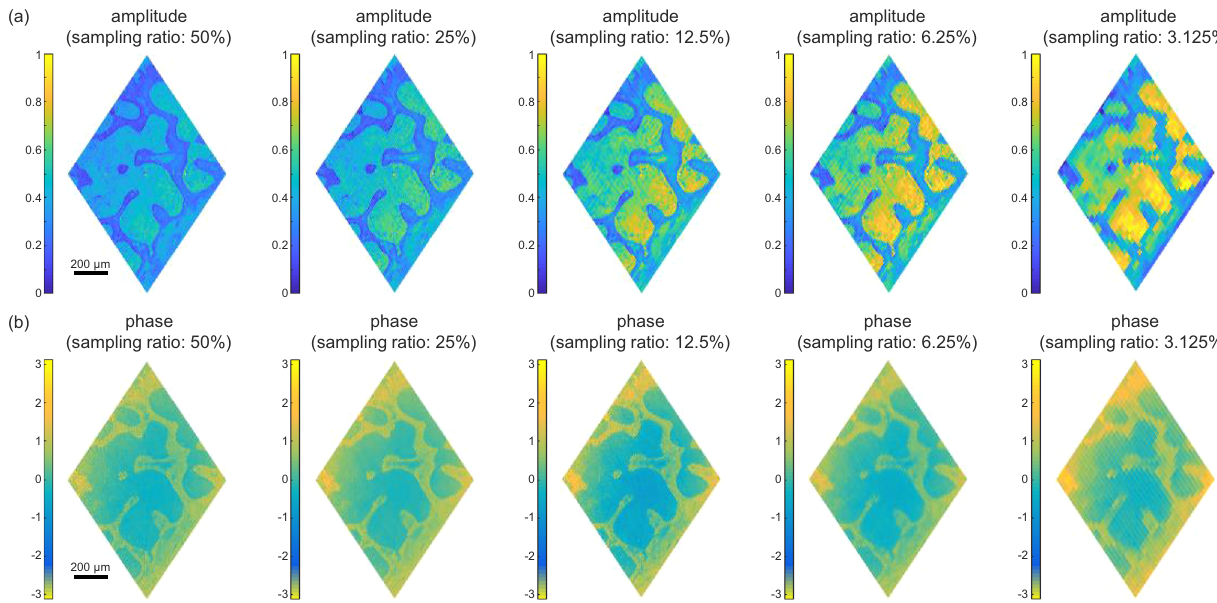
Fig. 3 Reconstruction of holographic images for the piece of mouse tail with compressive sensing. The amplitude and wrapped phase images are reconstructed with different SRs of 50%, 25%, 12.5%, 6.25%, 3.125%. The corresponding scale bar is 200 μ